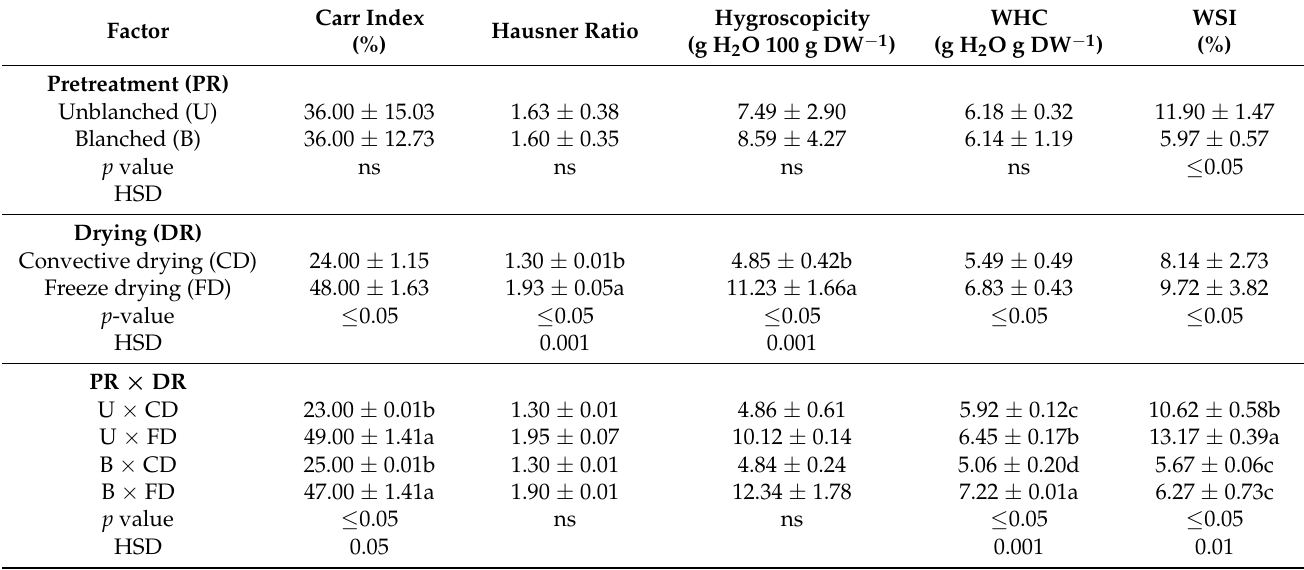
Table 2. The interaction effect of pretreatment (PR) and drying (DR) factors on the physicochemical and technological properties of nettle powders. Data are mean ± standard deviation of the mean. Mean values belonging to the same factor without common letters are statistically different according to the Honestly Significant Difference or HSD ( p ≤